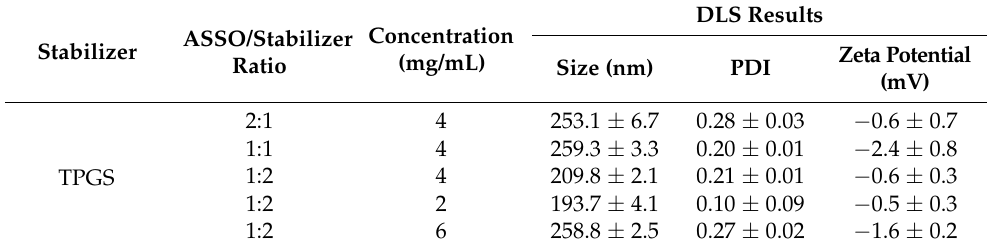
Table 2. Further optimization of ASSO-NPs prescription (mean ± SD, n = 3).